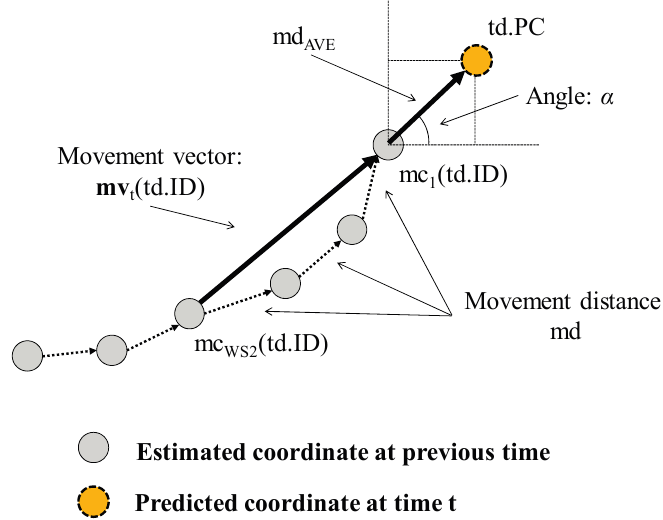
Figure 7. Example of the calculation of predicted next